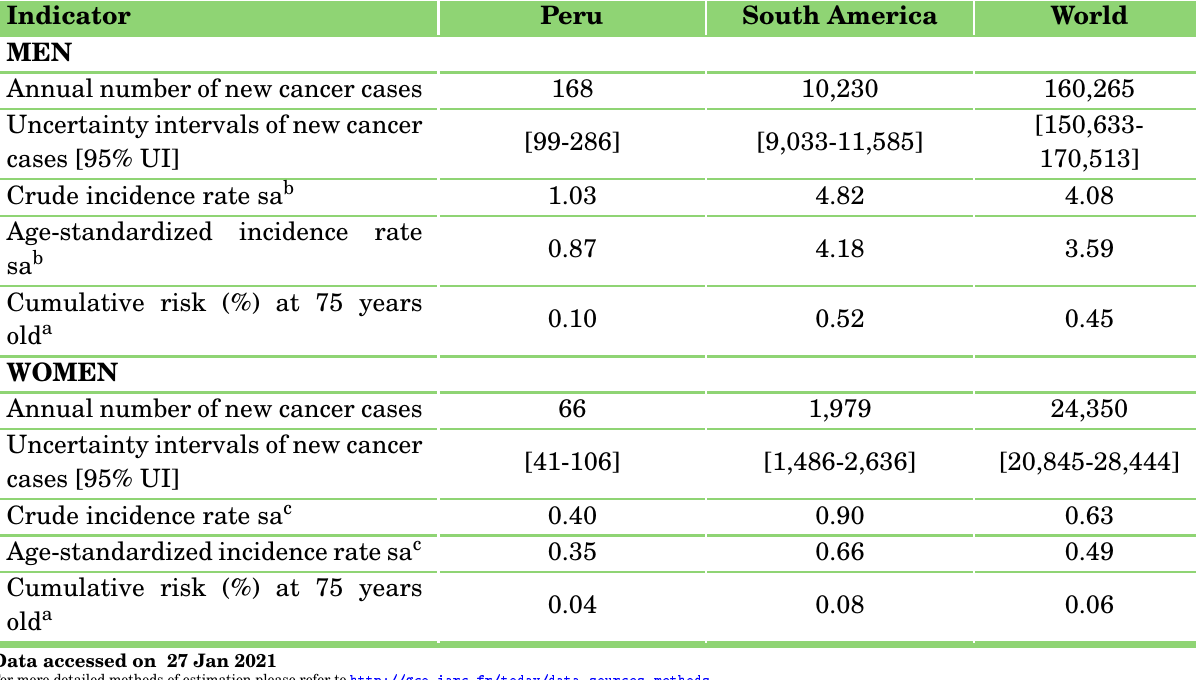
Table 19: Laryngeal cancer incidence in Peru (estimates for 2020) Indicator